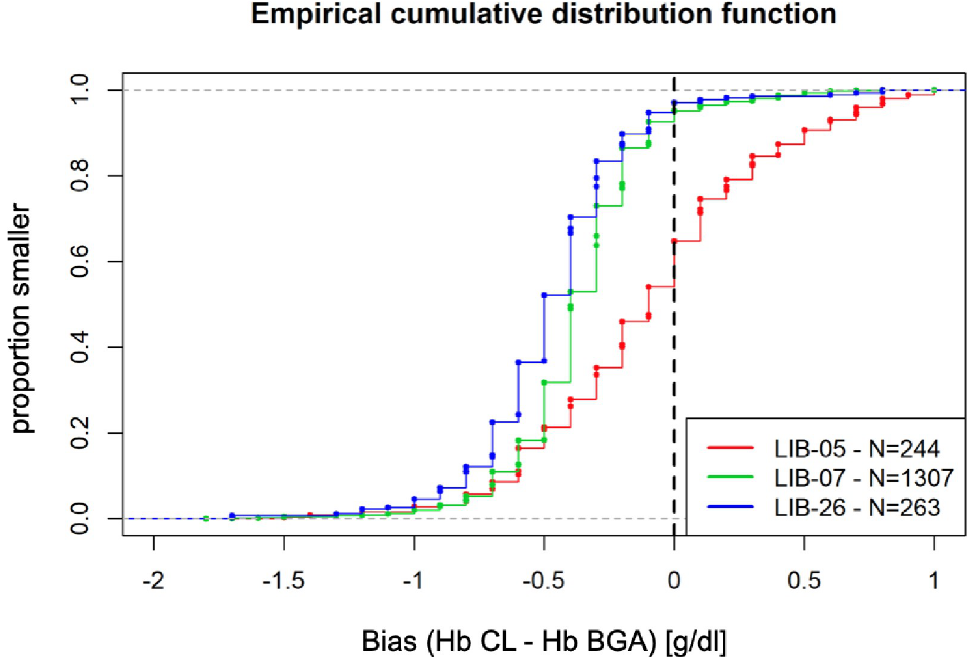
Fig 1. Comparison of the bias. Empirical cumulative distribution function was applied to detect potential bias between centers (LIB-05, LIB-07 and LIB-26). Hb = hemoglobin, CL central lab, BGA = blood gas analysis, LIB-05 = Bonn, LIB- 07 = Lrankfurt, LIB-26 =